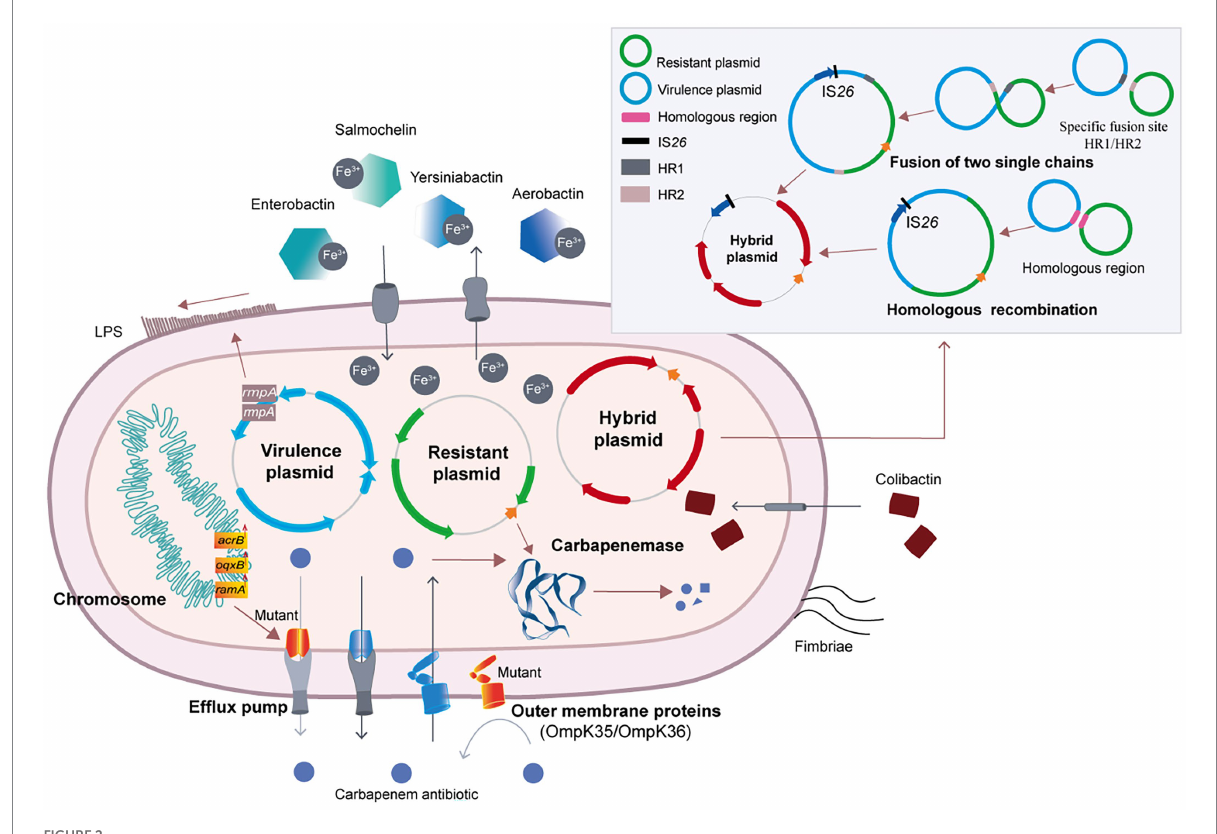
FIGURE 2 The molecular evolution and carbapenem-resistance mechanism of